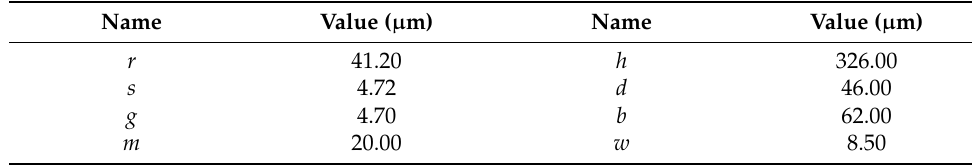
Table 1. Parameters of the optimized array antenna.